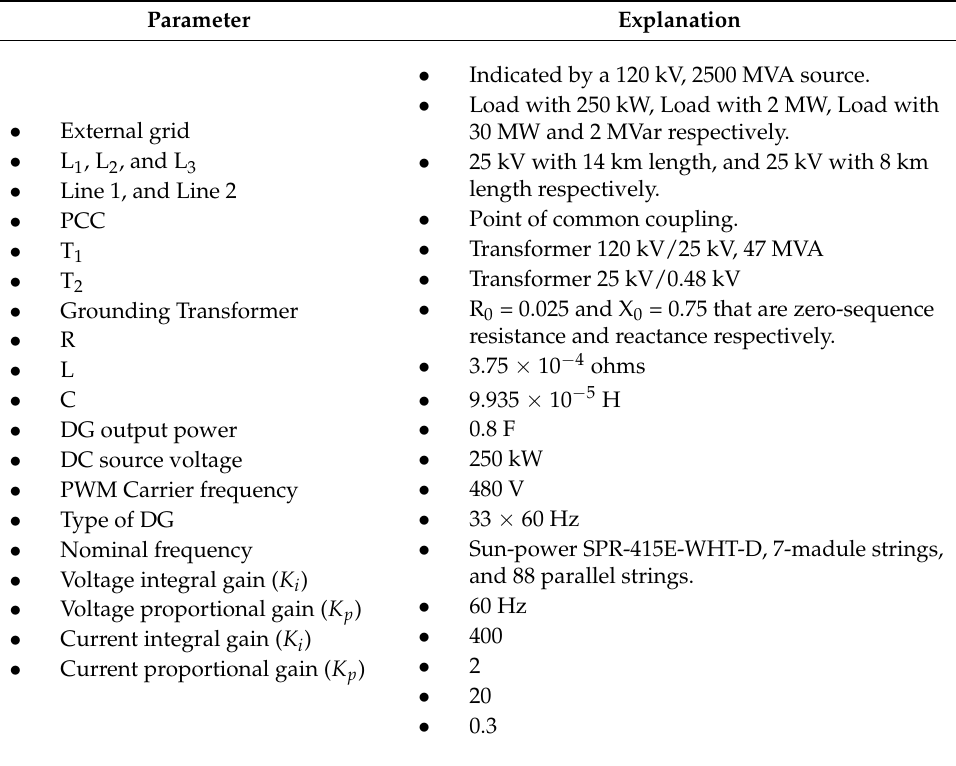
Table A1. System’s parameters.